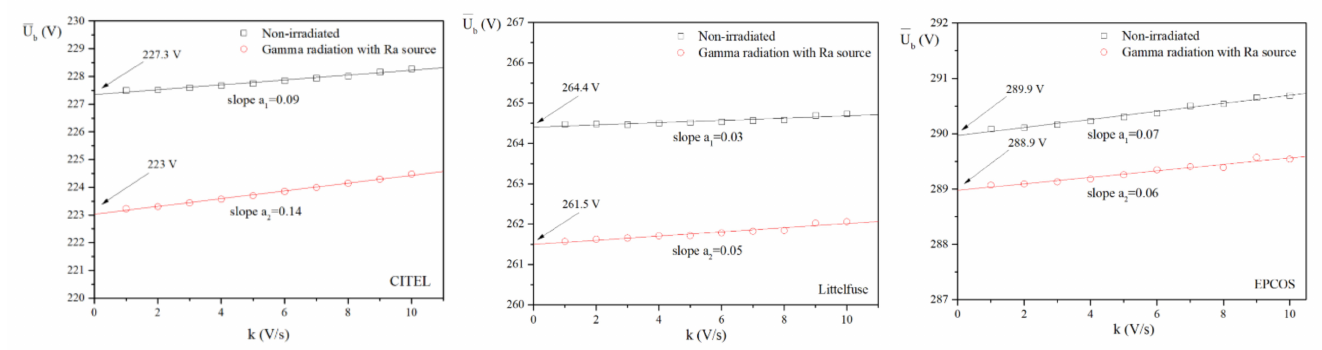
Figure 4. Mean value of breakdown voltage as a function of voltage increase rate for non-irradiated and gamma radiation with Ra source of CITEL, Littelfuse and EPCOS GFSA,